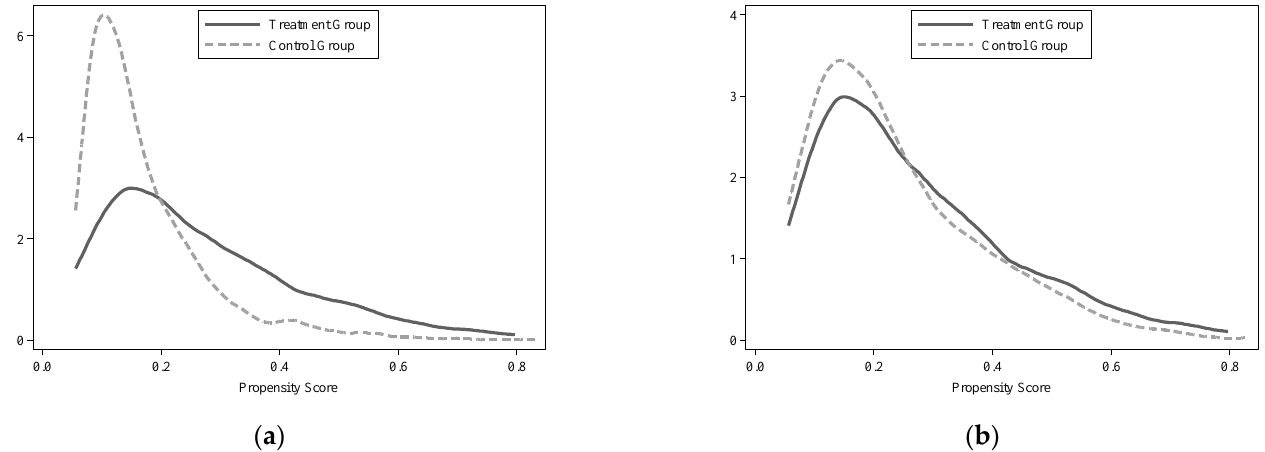
Figure 2. Distribution of propensity scores by treatment and control groups: before and after the neatest-neighbor PSM. ( a ) Before matching, ( b ) after matching. Table 3. Balancing test results.